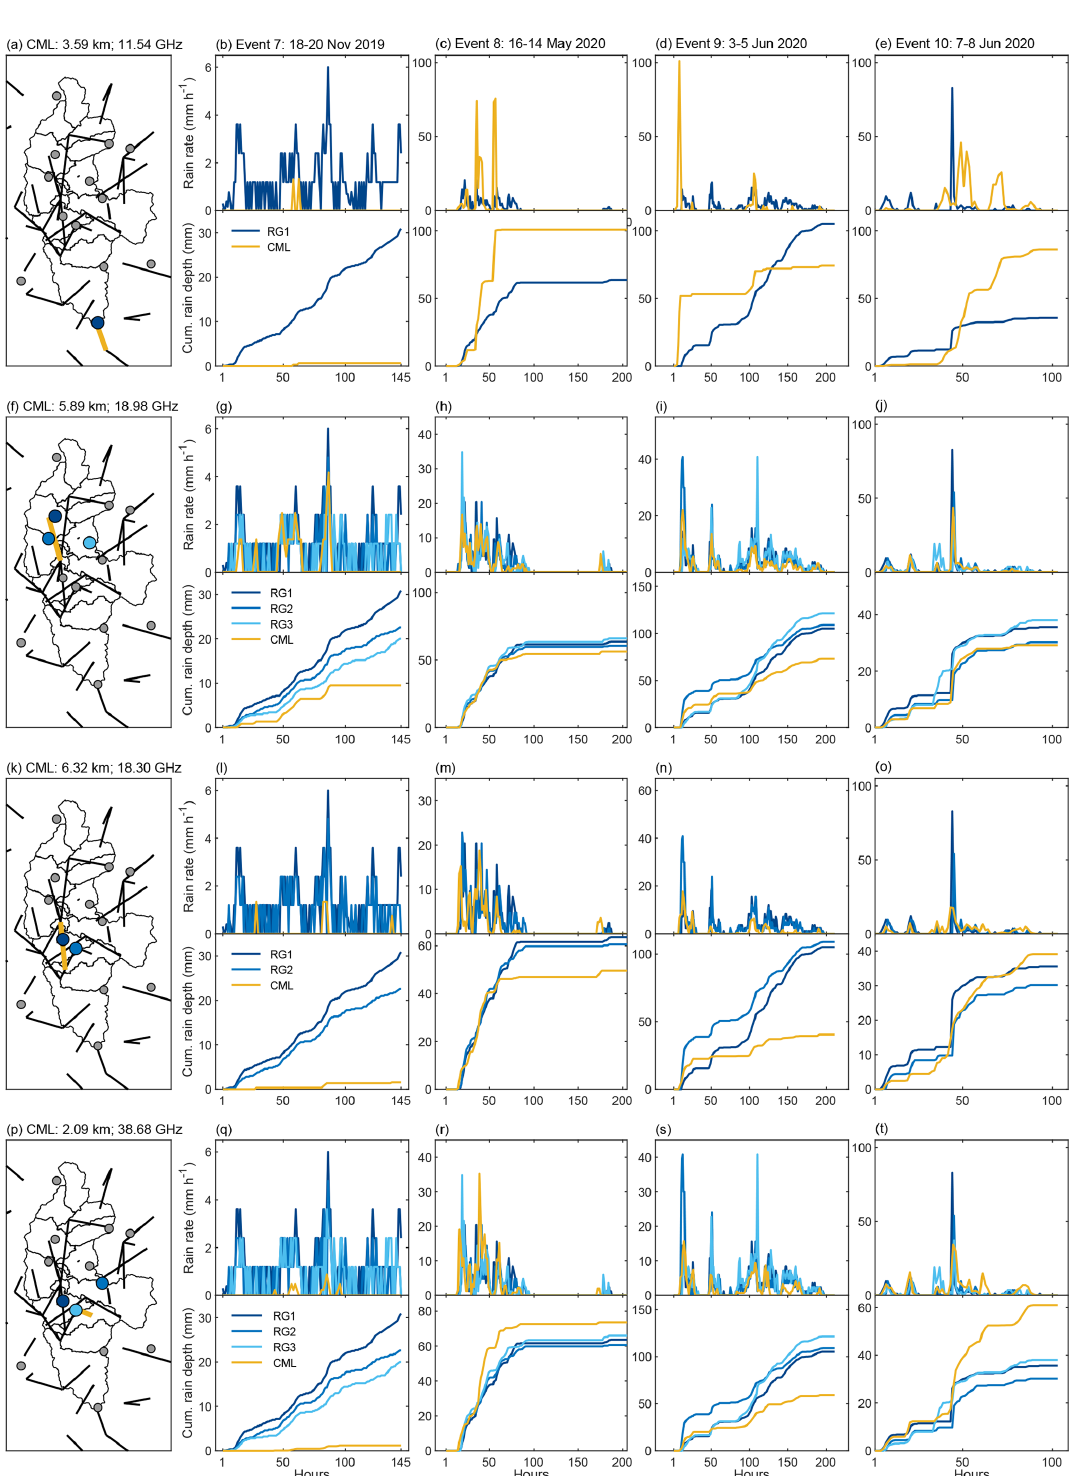
Figure A1. Comparison between single CMLs and their nearby RGs. Each row shows (1) the location of the selected CML in the Lambro Basin and its nearby RGs, (2) the CML–RGs comparison with respect to the rain rate time series, and (3) the CML–RGs comparison with respect to the cumulated rainfall